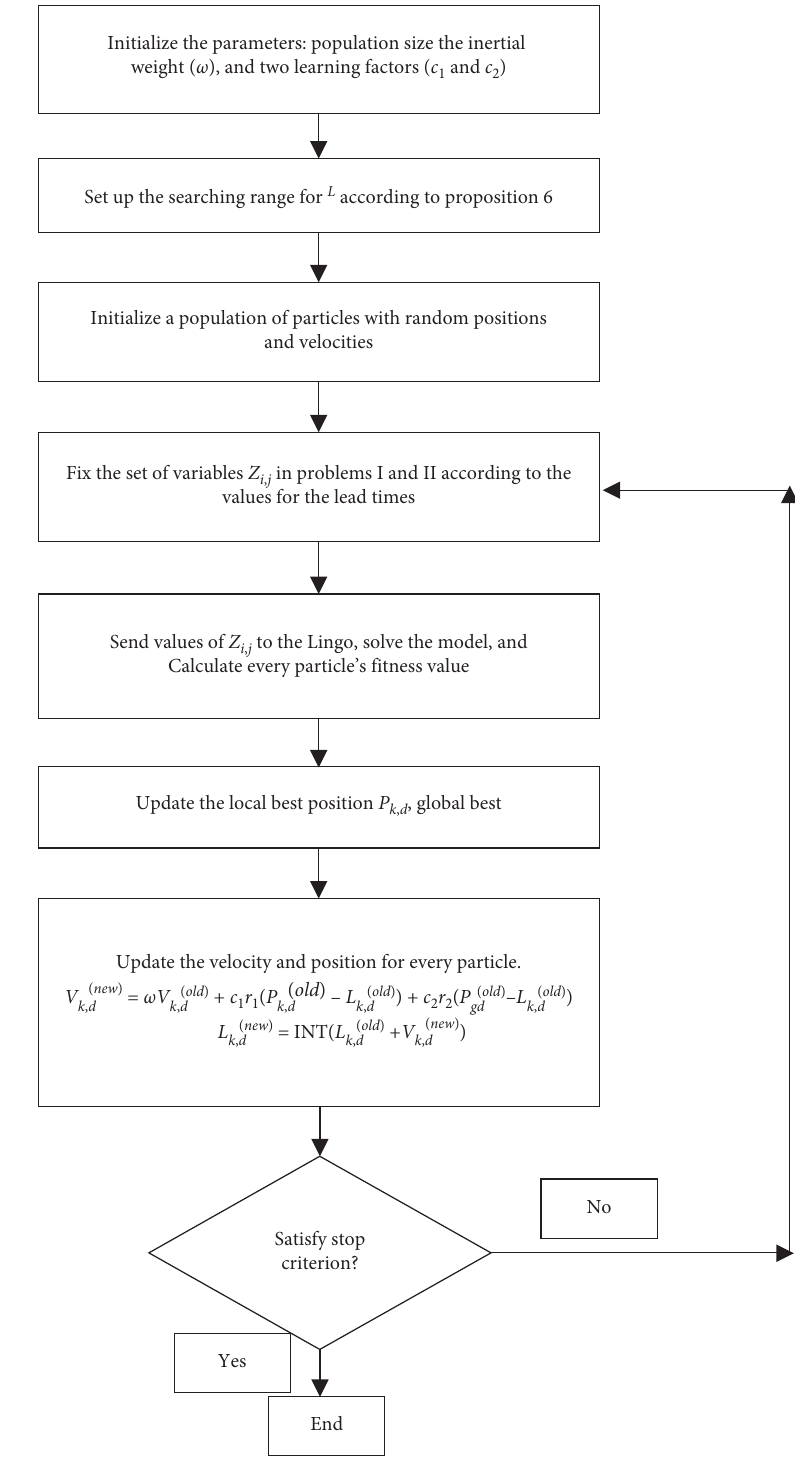
Figure 1: PSO flowchart for pricing and due date